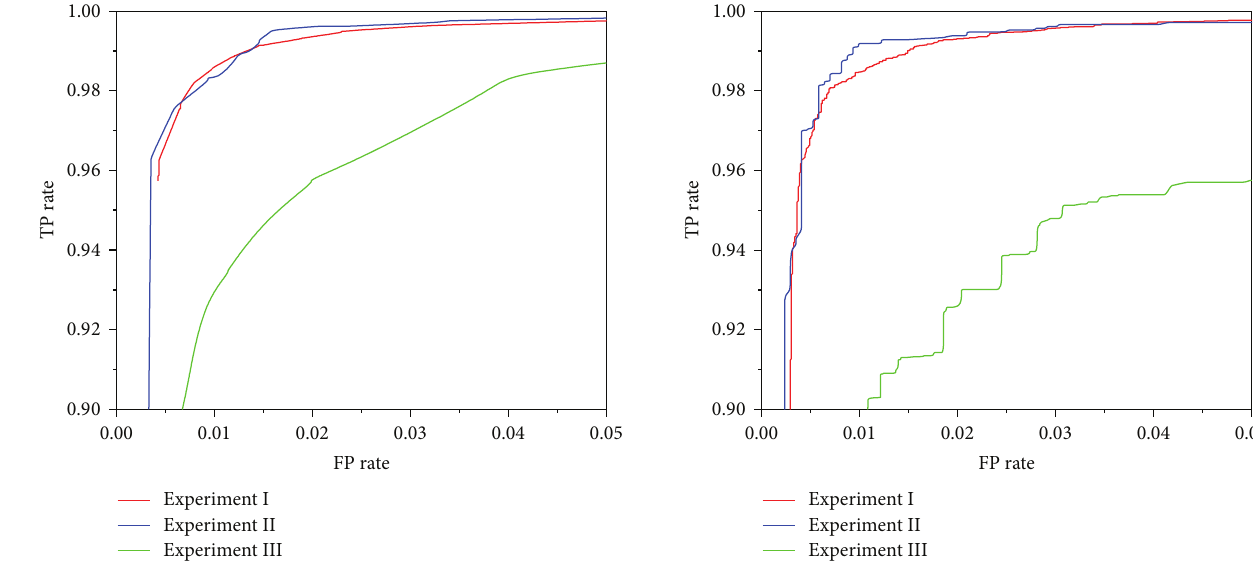
Figure 6: ROC curves for bagging (J48) classification algorithm.